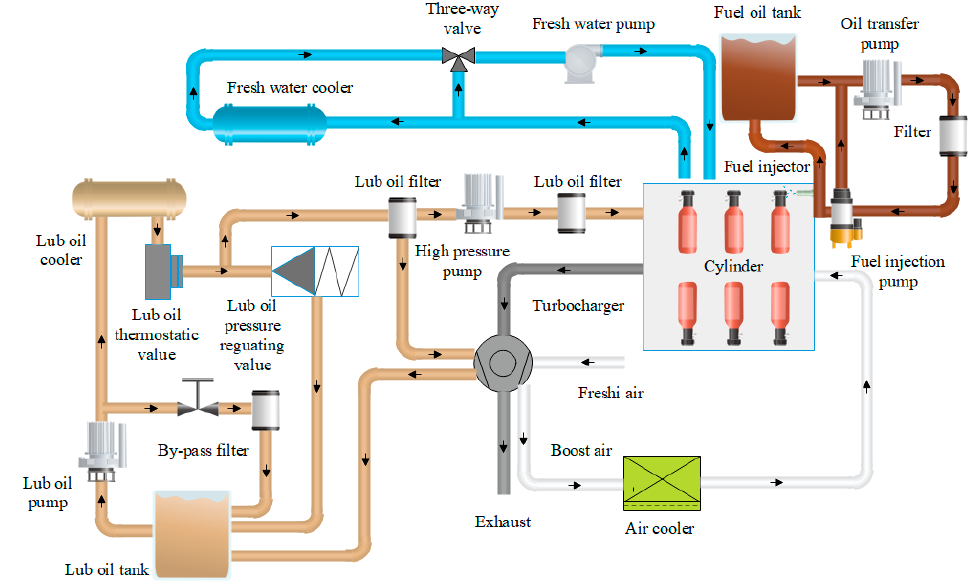
Figure 3. Sketch of the composition structure.